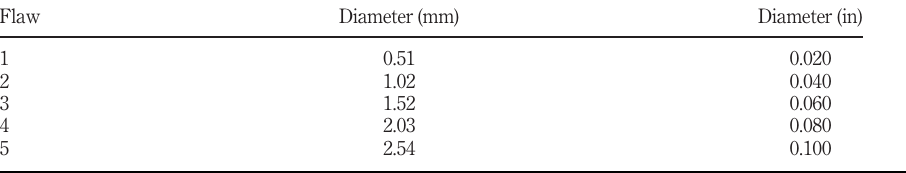
Figure 1. Design of